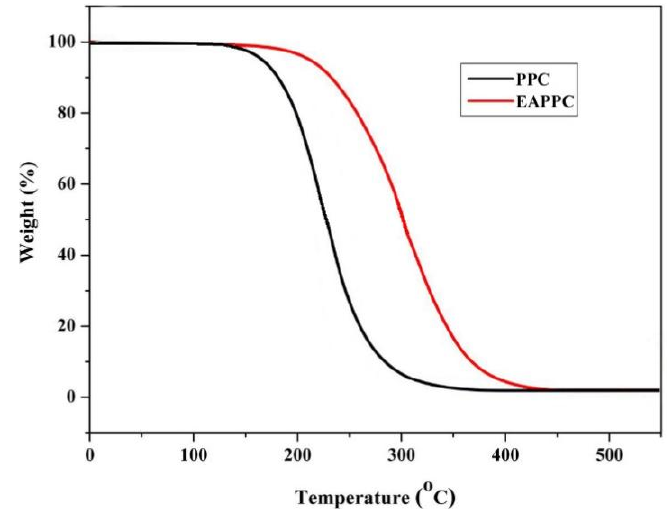
Figure 1. TGA curves of PPC and EA–PPC.